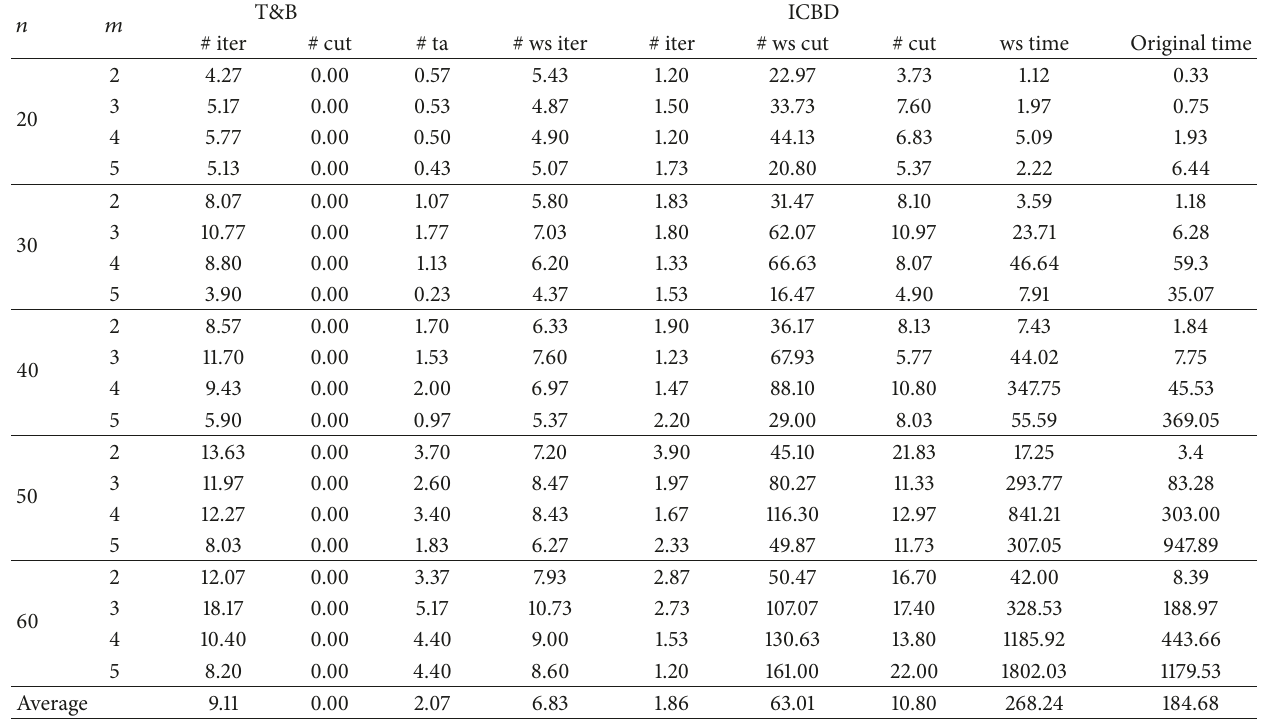
Table 4: Comparison of T&B and ICBD relative to traditional and proposed convergence acceleration